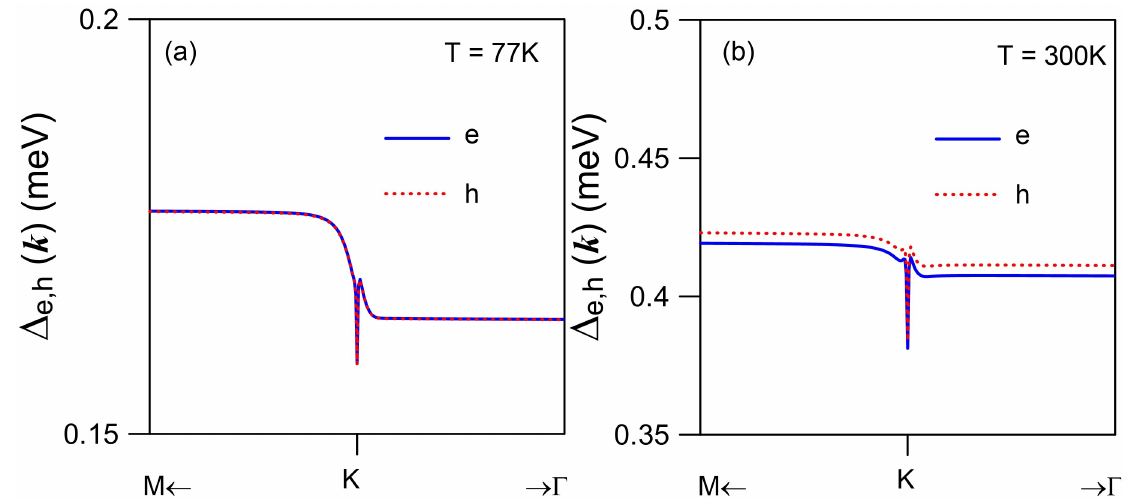
Figure 9. Calculated Coulomb diagonal-dephasing rates ∆ e,h ( k ) for electrons (e, blue solid curves) from Equation (34) and ∆ ( k ) for holes (h, red dashed curves) from Equation (40) as functions of wave number k (with respect to k = 0 at the K h valley) at temperatures T = 77K in ( a ) and T = 300K in ( b ), where (cid:101) r = 2.4 and Γ e = Γ h = 0.01meV are